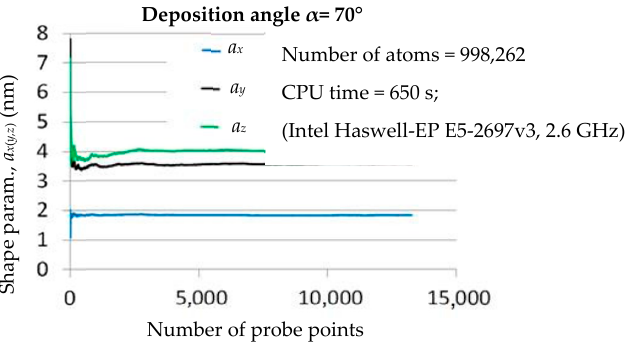
Figure 6. Dependence of the shape parameters on the number of probe points in Monte Carlo simulation .